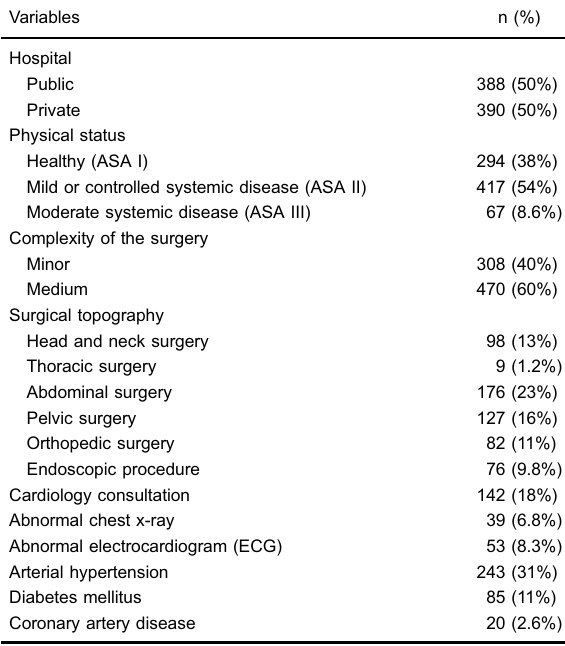
Table 2. Clinical and anthropometric data of patients scheduled for low and medium risk surgeries with moderate functional capacity ( X 4 MET, metabolic equivalents), in Salvador, BA, Brazil